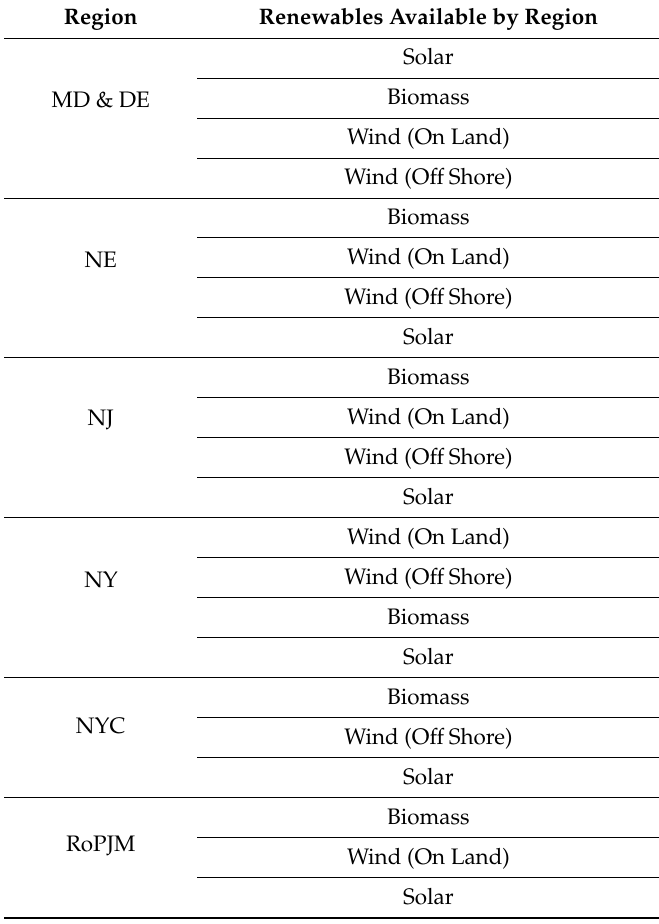
Table A11. Available Renewables by Region (General Electric International,